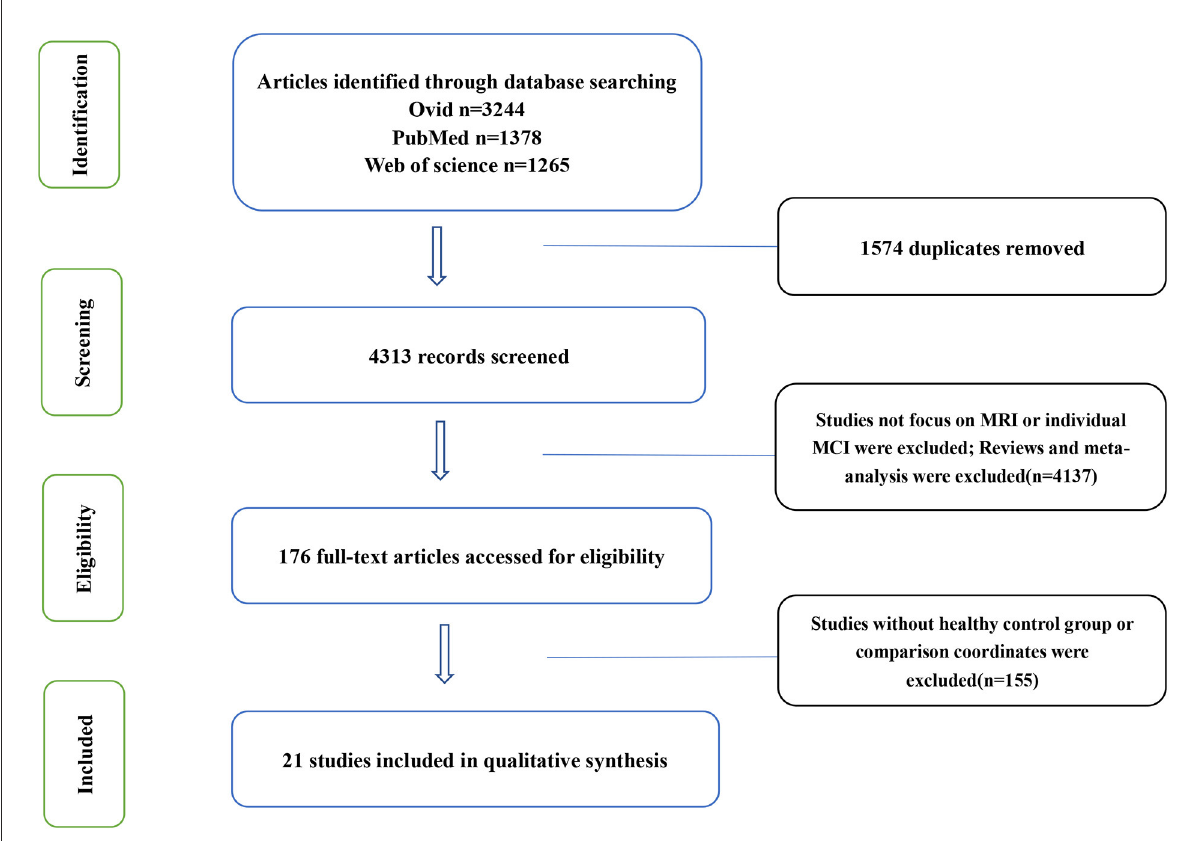
FIGURE1 Flow of information through different phases of a systematical